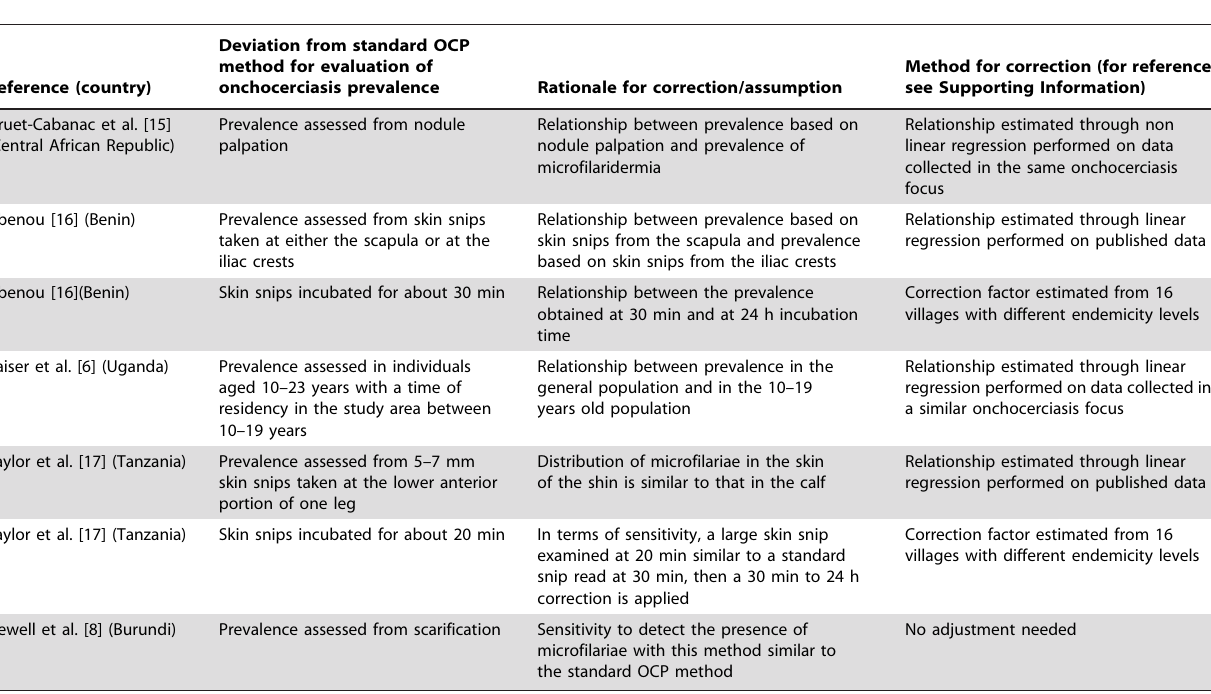
Table 1. Methodological departures from the standard OCP procedure to assess onchocerciasis infection status and proposed procedures to minimize the effect of these deviations on onchocerciasis